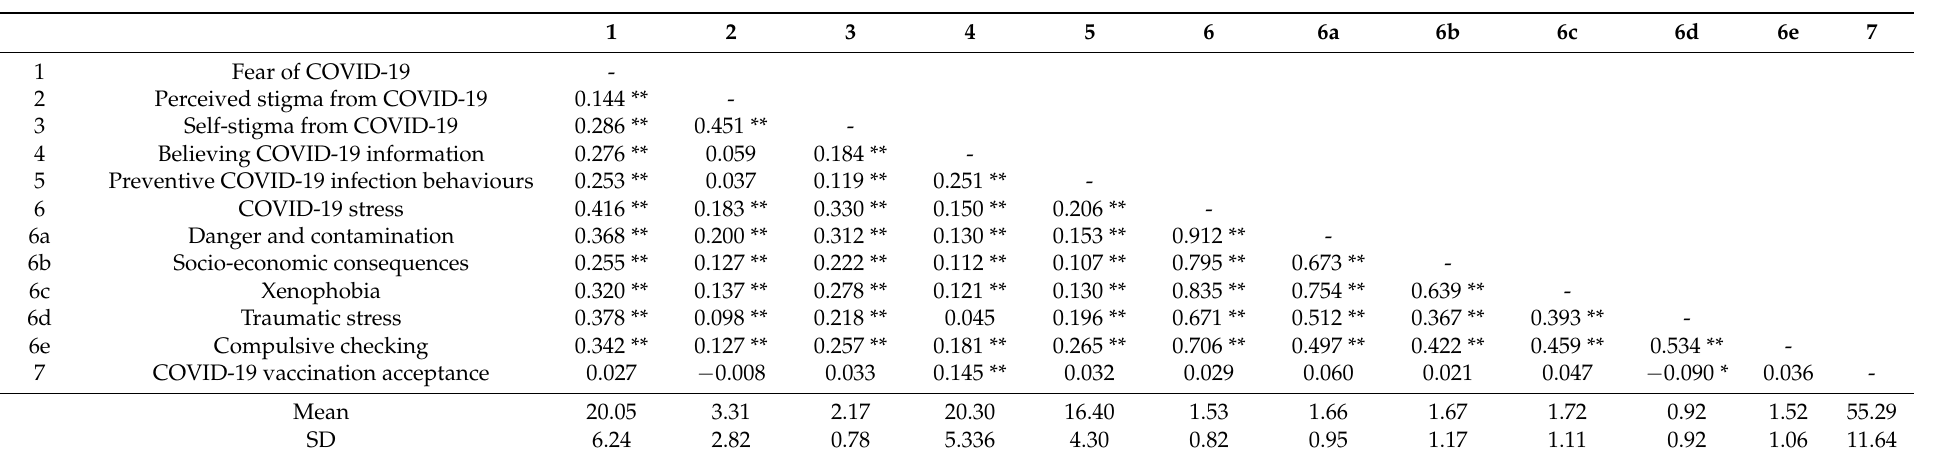
Table 3. Correlation matrix of the studied